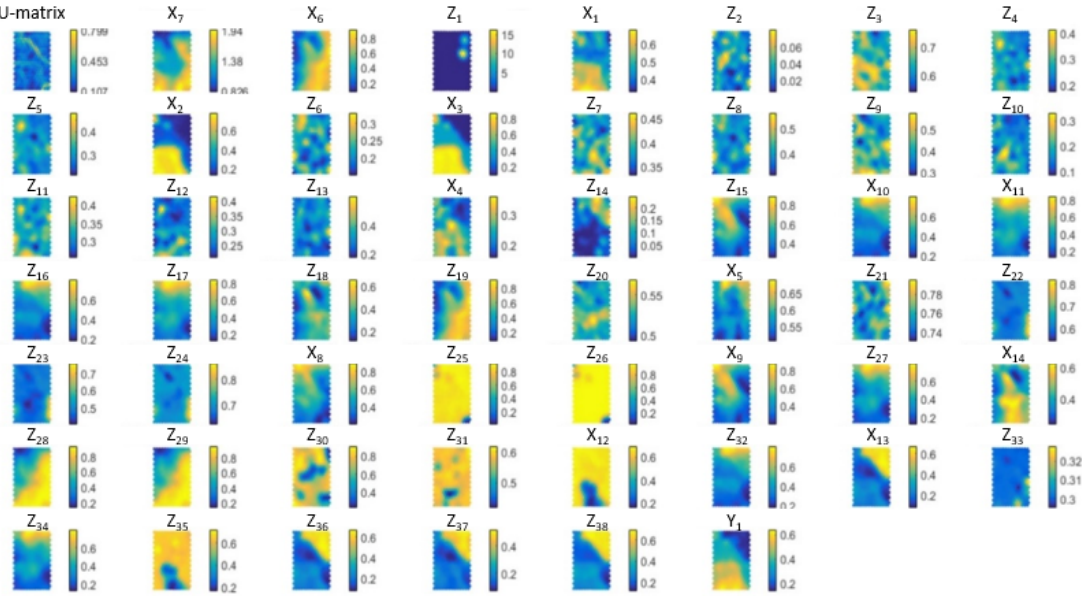
Figure 3. Output of the Self-Organized Maps (SOM) analysis for the initial set of parameters. Table 1. List of variables discarded by means of the SOM analysis.